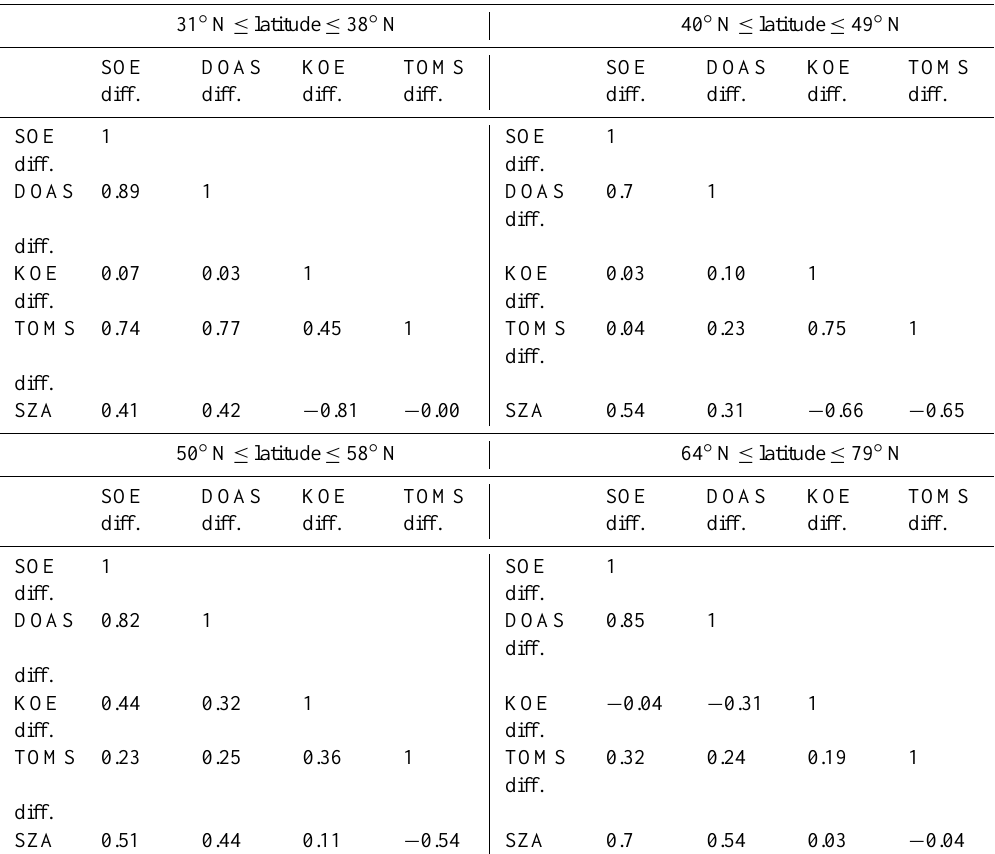
Table 4. Correlations ( R ) between OMI–Brewer monthly mean total ozone differences of the four products (rows 1–4) and monthly solar zenith angle (row